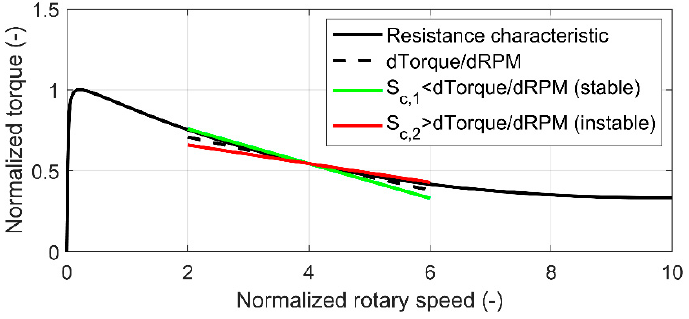
Figure 1. Nonlinear torque characteristic at the bit cf. [8].